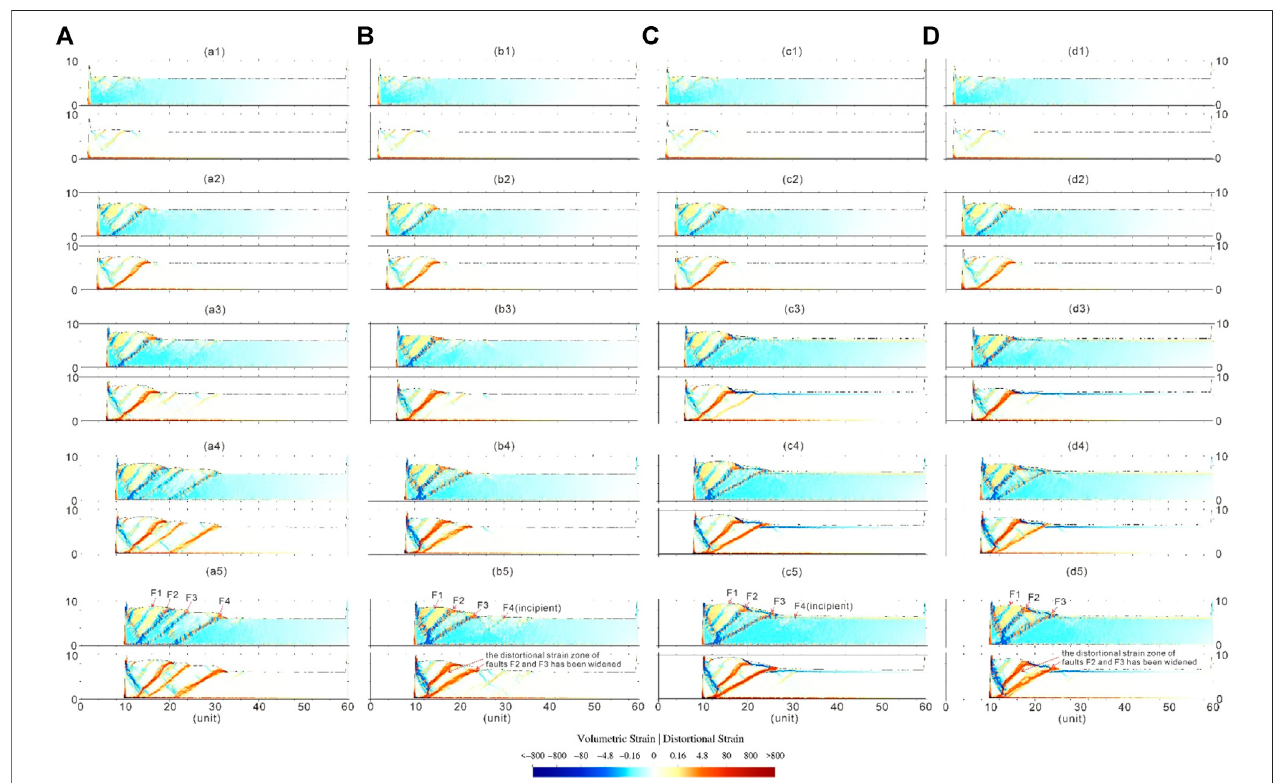
FIGURE 9 | Strain analysis of DEM simulations in Model 1 (A) , Model 2 (B) , Model 3 (C) , and Model 4 (D) . Volumetric strain (upper fi gure) and distortional strain (lower fi gure)arepresentedafterevery2unitsshortening.Involumetricstrainanddistortionalstrain,bluedenotevolumetriccontractionandtoptotheleftsenseofshear, respectively, whereas red denote volumetric dilation and top to the right sense of shear,